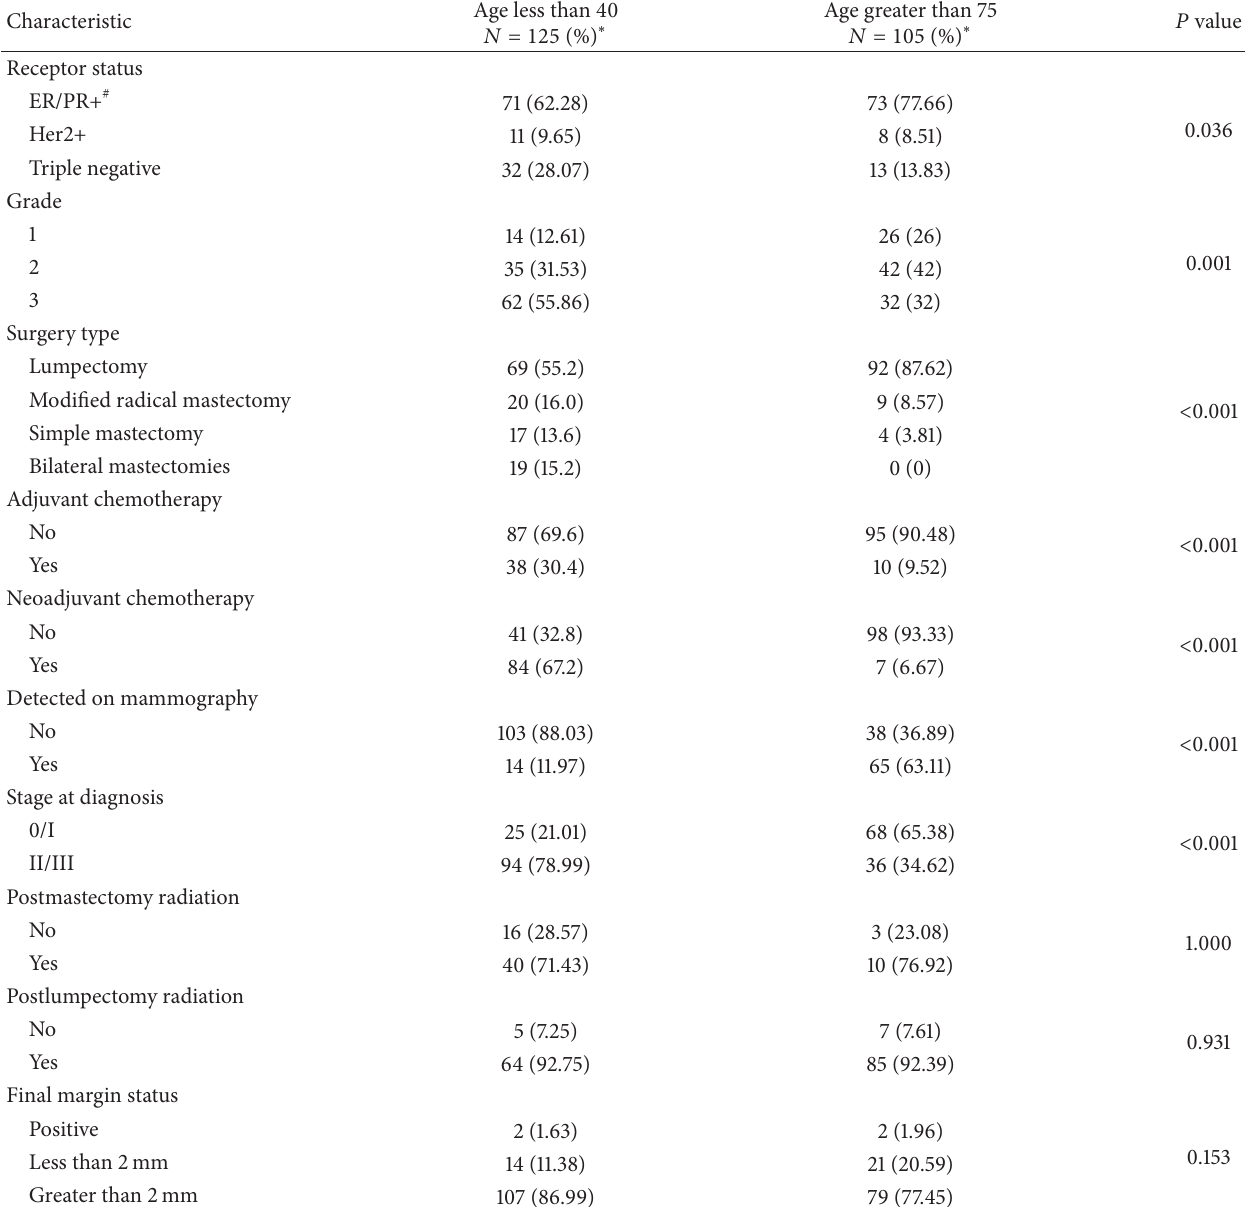
Table 1: Breast cancer characteristics in younger and older